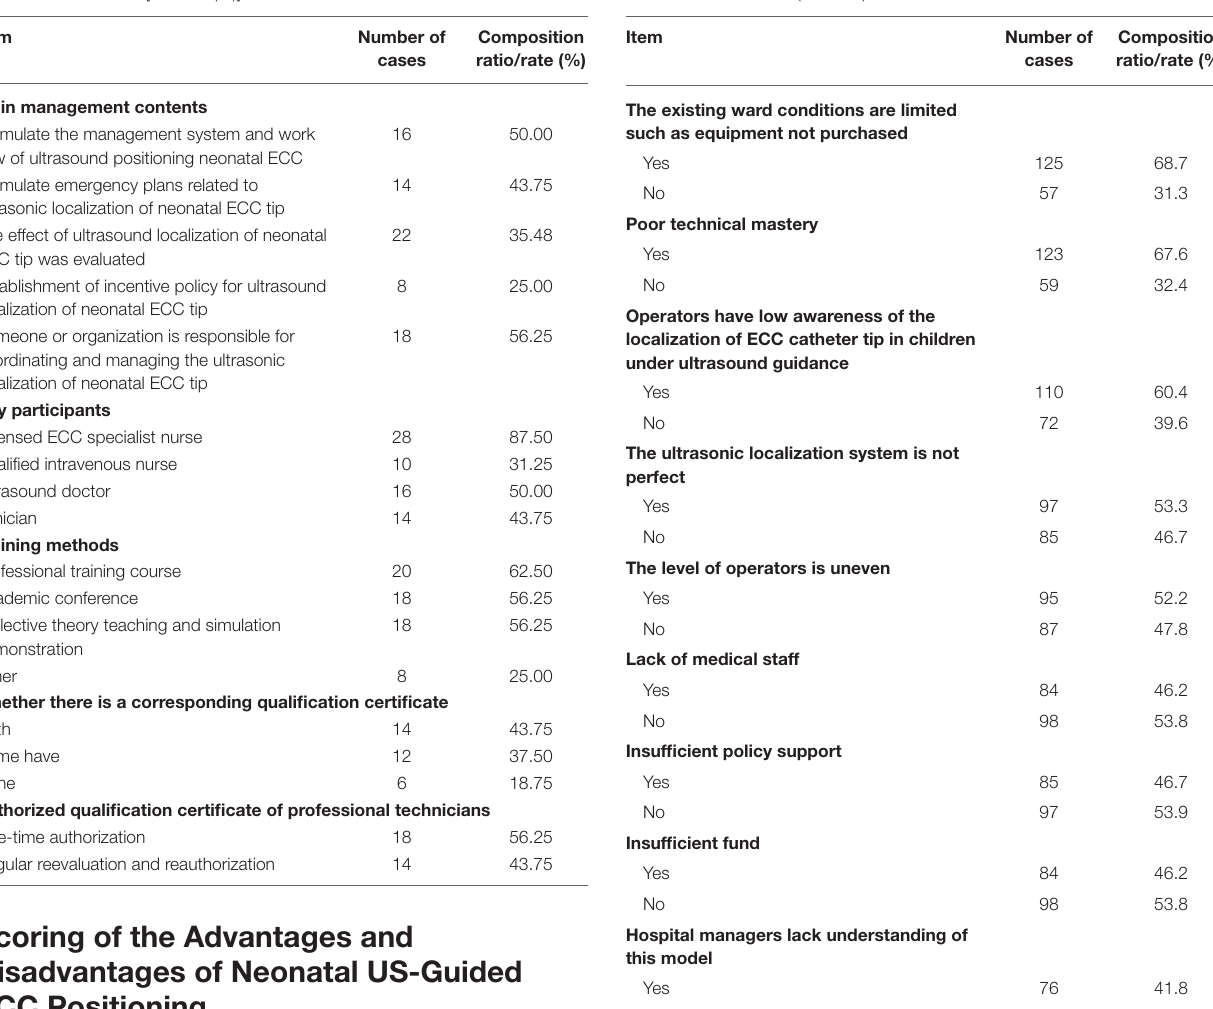
TABLE 6 | Investigation of obstacles affecting the hospital to carry out neonatal ultrasound localization ( n =